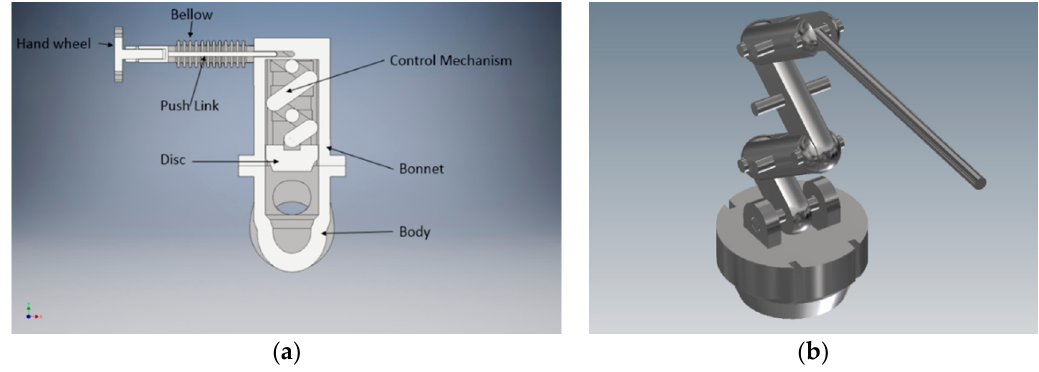
Figure 3. ( a ) Globe valve with designed mechanism. ( b ) Isometric view of mechanism.